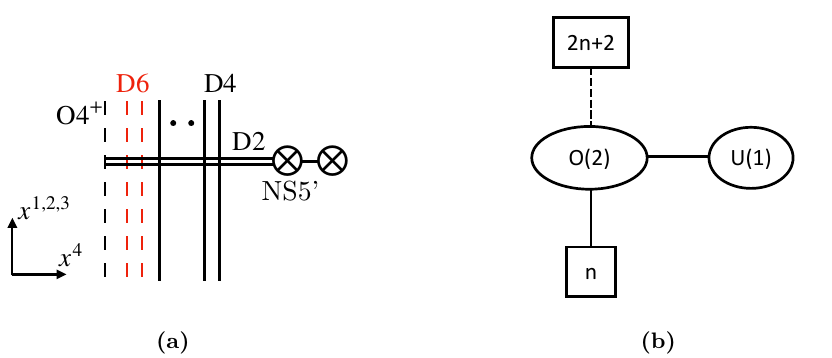
Figure 21. (a): the brane configuration for the monopole screening contribution to the v = 0 sector in T V · T V . (b): the corresponding quiver